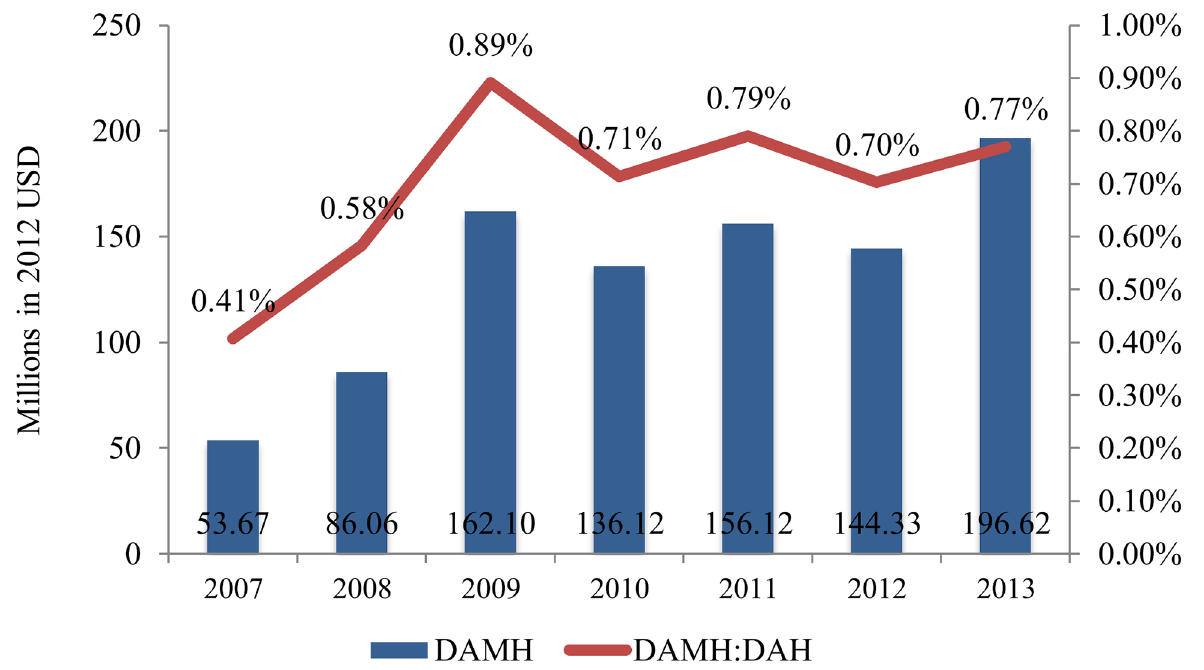
Fig 1. Trends in annual DAMH and its proportion of DAH, 2007 –